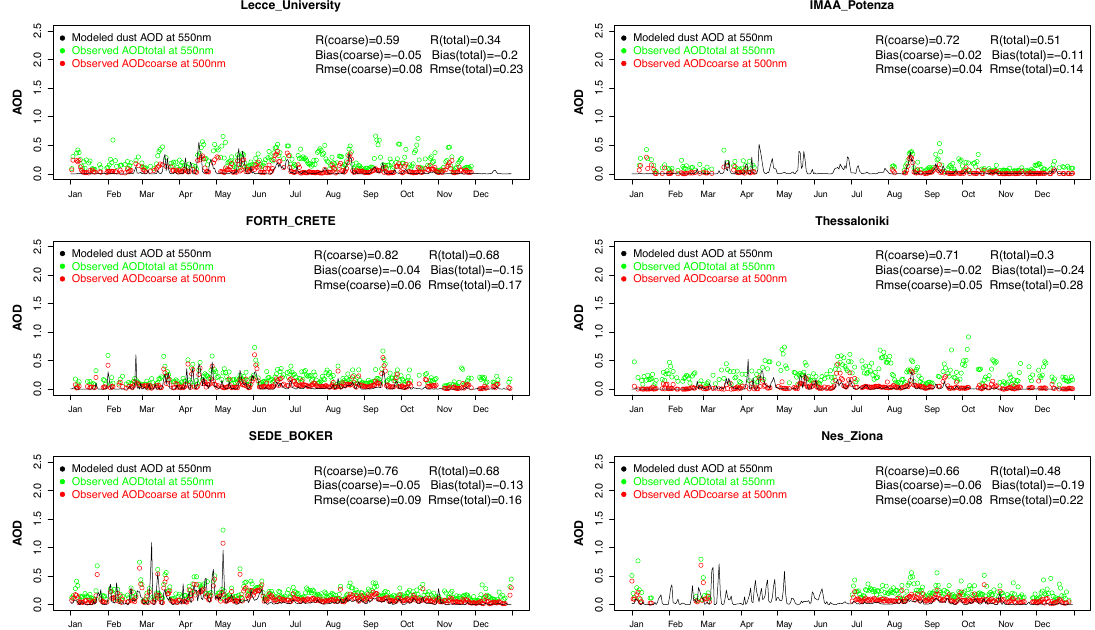
Fig. 8. Daily AOD average of model vs. AERONET stations in the Central (Lecce University and IMMA Potenza) and Eastern Mediter- ranean (Forth Crete, Thessaloniki, Sede Boker and Nes Ziona) for 2006. Model averages (black lines) represent the dust AOD at 550nm. Observations include AODtotal (green circles) and AODcoarse (red circles). Each panel includes the correlation ( R ), bias and root mean square error (RMSE) between the model and AODcoarse and